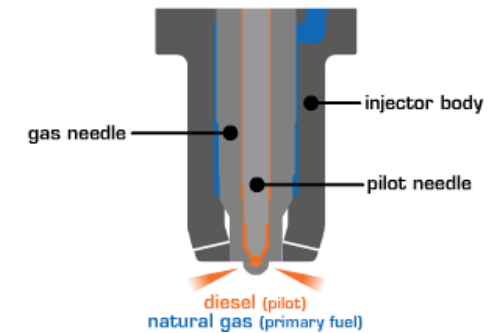
Fig. 21. Scheme of Westport company HPDI Injector Tip Assembly (re- produced from